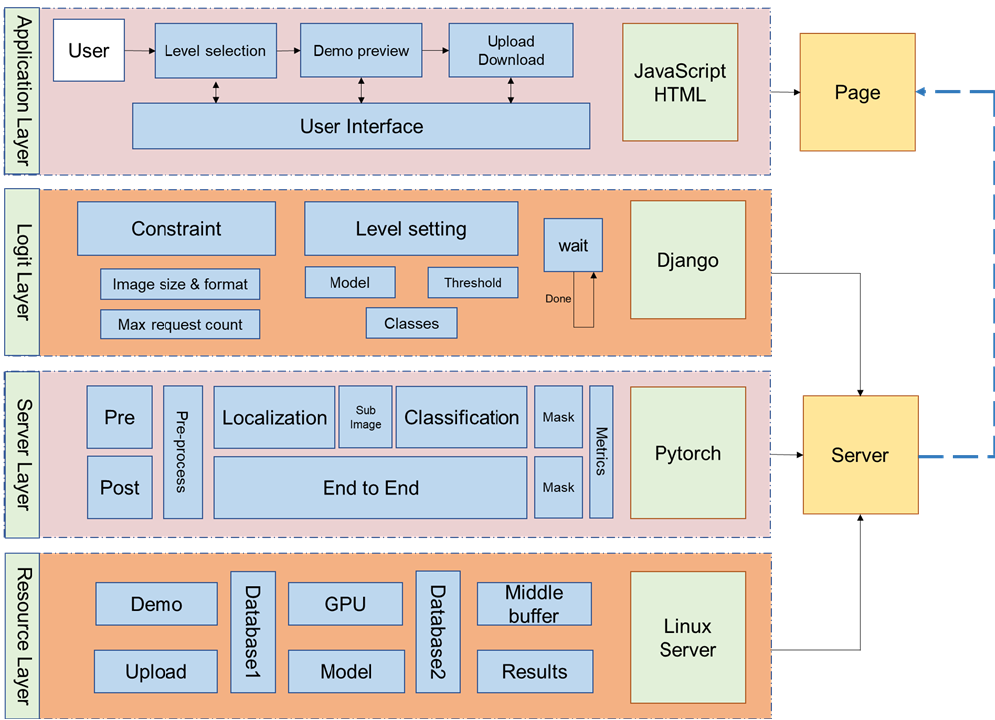
Figure 12. The overall structure of the AI-driven Damage Diagnosis Platform (ADDP). It has a service-oriented architecture containing the following four layers: an application layer, a logic layer, a service layer, and a resource